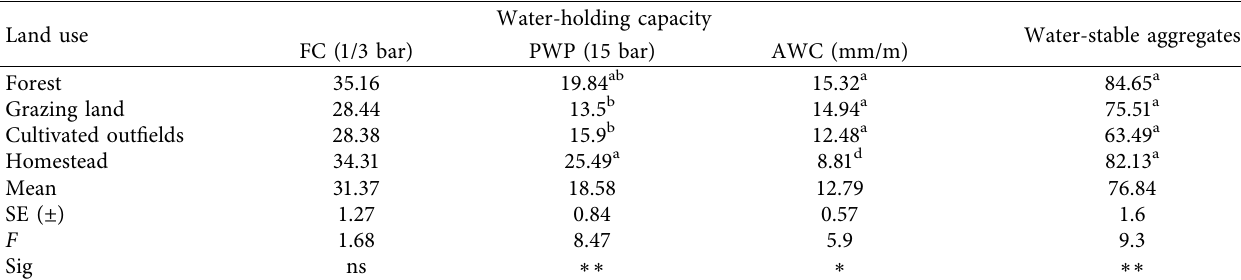
Table 3: Mean values of some selected physical properties of soils as affected by land